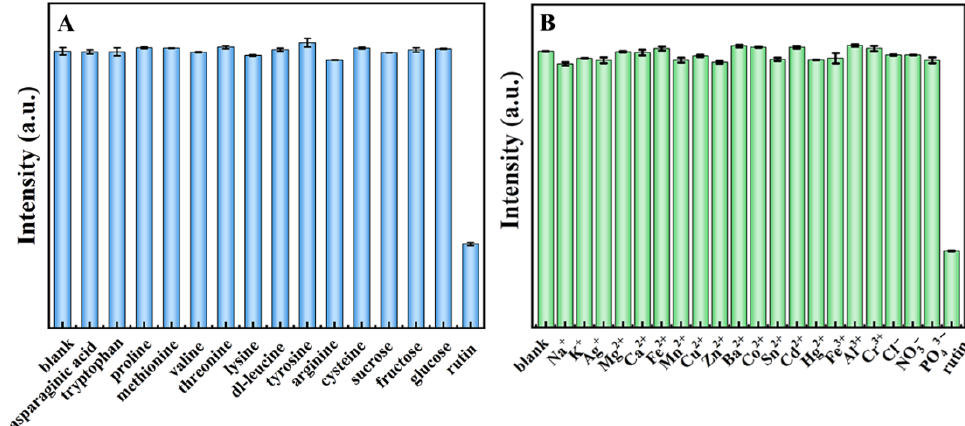
Figure 5. Effects of coexisting different amino acids (100 μ M) ( A ) and metal ions (100 μ M) ( B ) with rutin (45 mg·L − 1 ) on the fluorescence intensity of N, S-CDs.